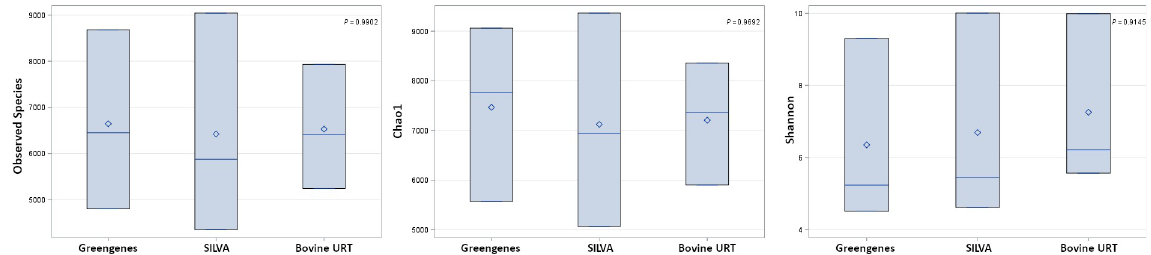
Fig 5. Boxplots of alpha diversity indices among Greengenes, SILVA, and Bovine URT database microbial profiling methods. Alpha diversity indices include A) observed species, B) Chao1, and C) Shannon diversity index.